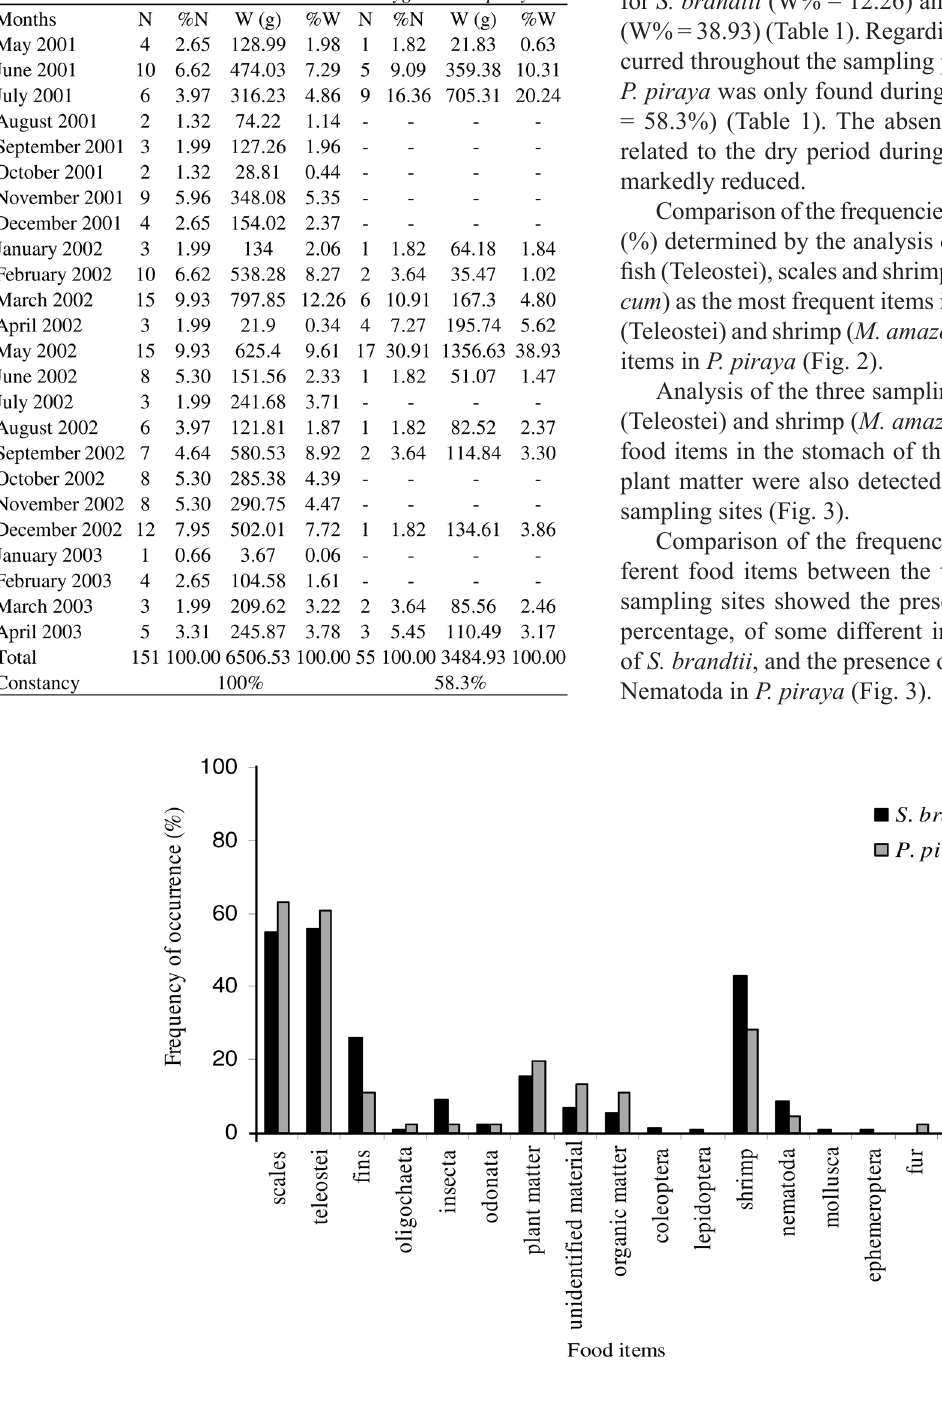
Fig. 2. Total frequency of occurrence (%) of different food items determined by the analysis of the stomach content of Ser- rasalmus brandtii and Pygocentrus piraya collected between May 2001 and April 2003 according to the three sampling